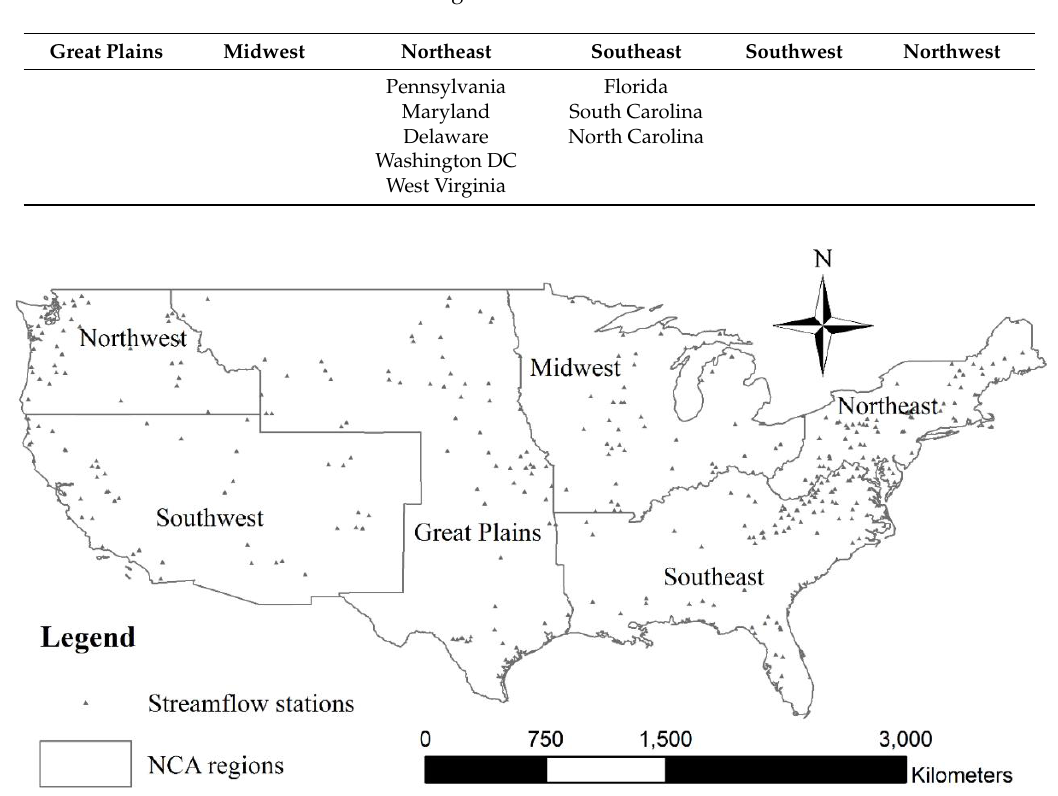
Table 2. The number of stations, data range, and the total percentage of variance explained by the first principal component (FPC) in each of the NCA regions.